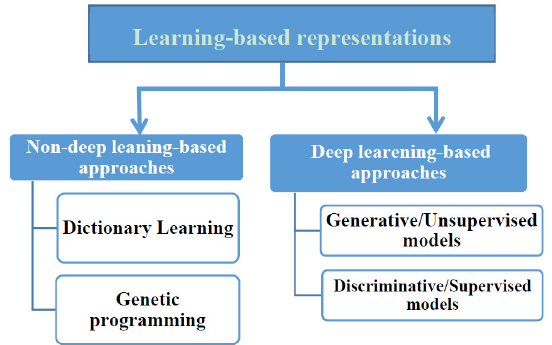
Figure 7. Learning ‐ based action representation approaches. Figure 7. Learning-based action representation